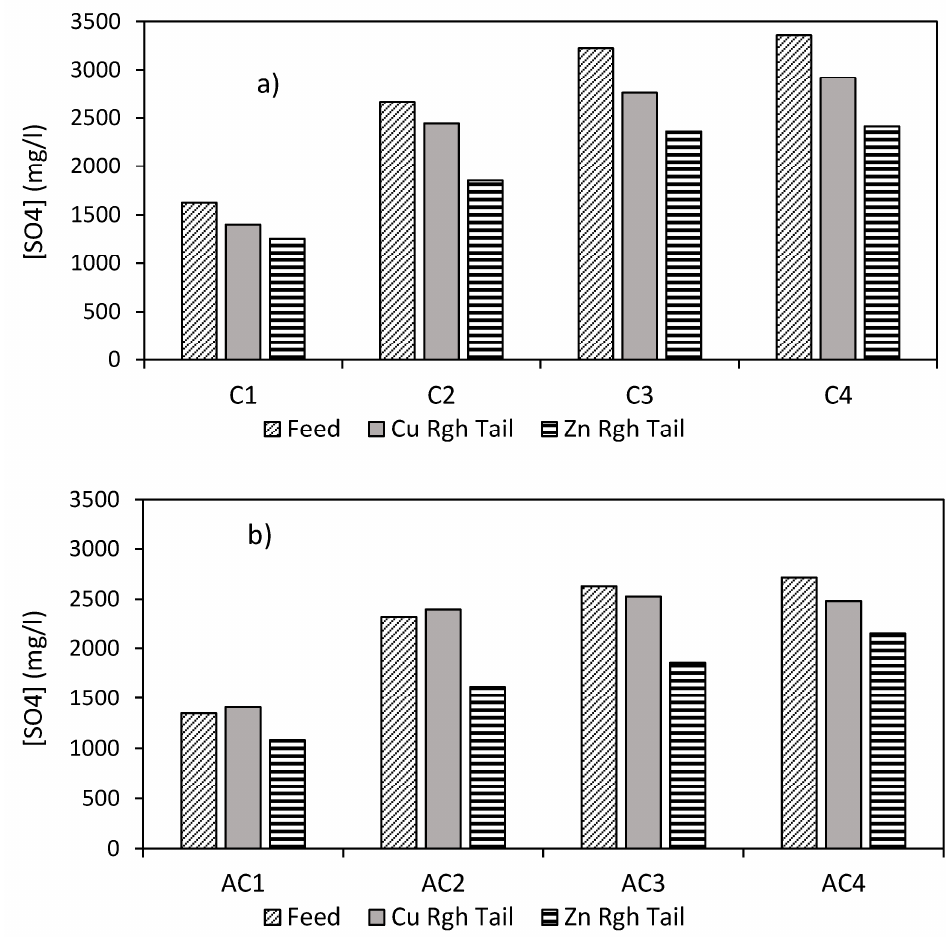
Figure 6. Dissolved ion concentration of sulfate ions at different stages of flotation tests during water recirculation without ( a ) and with ( b ) treatment.